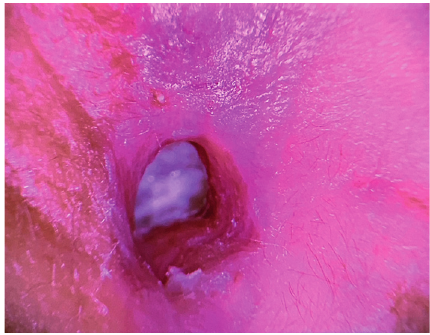
Figure 9: Day 45 view of the right external auditory canal with an intact tympanic